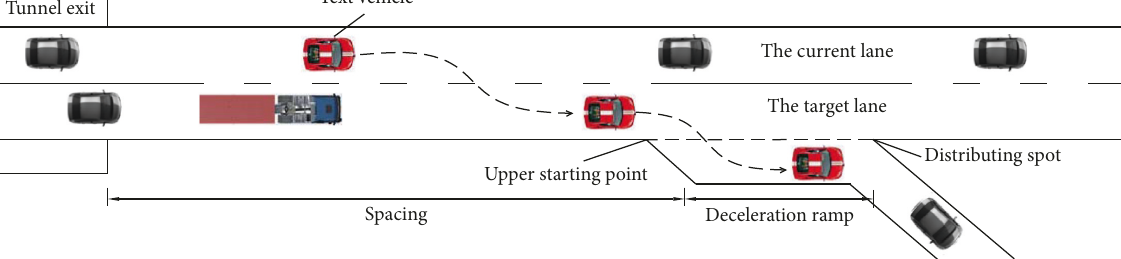
Figure 1: Simplified lane change model of small spacing section.